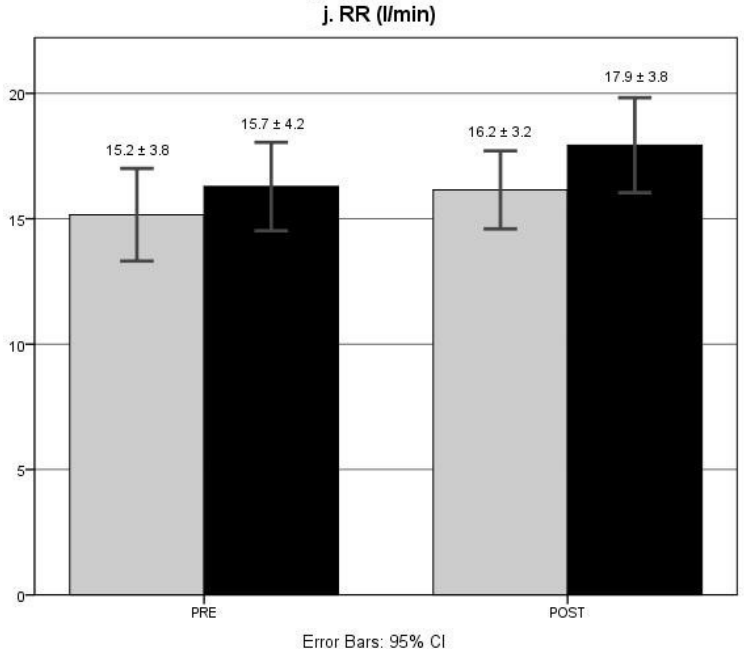
Figure 3. Means and standard deviations of autonomic outcome measures. The specific outcome measure each figure refers to is in depected in the figure itself. ( a ) HR (bpm); ( b ) HRV RMSSD (ms); ( c ) HRV LF (m 2 ); ( d ) HRV HF (ms 2 ); ( e ) The LF/HF ratio; ( f ) ST ( ◦ C); ( g ) SCL ( µ S); ( h ) SCR; ( i ) PB (mmHg); ( j ) RR (I/min). Legends: The y -axis represents the quantification of the measure, the x -axis represents the time point of the measure (PRE: measure taken prior to exercise, DURING: measure taken during exercise, POST: measure taken post-exercise). Gray bars: healthy controls, black bars: ME/CFS. Abbreviations: BP: blood pressure, bpm: beat per minute, CI: confidence interval, HR: high frequency, HR: heart rate, HRV: heart rate variability, LF: low frequency, ME/CFS: Myalgic Encephalomyelitis/Chronic Fatigue Syndrome, RMSSD: root mean square of successive differences between NN intervals, RR: respiration rate, SCL: skin conductance level, SCR: skin conductance response, ST: skin temperature.